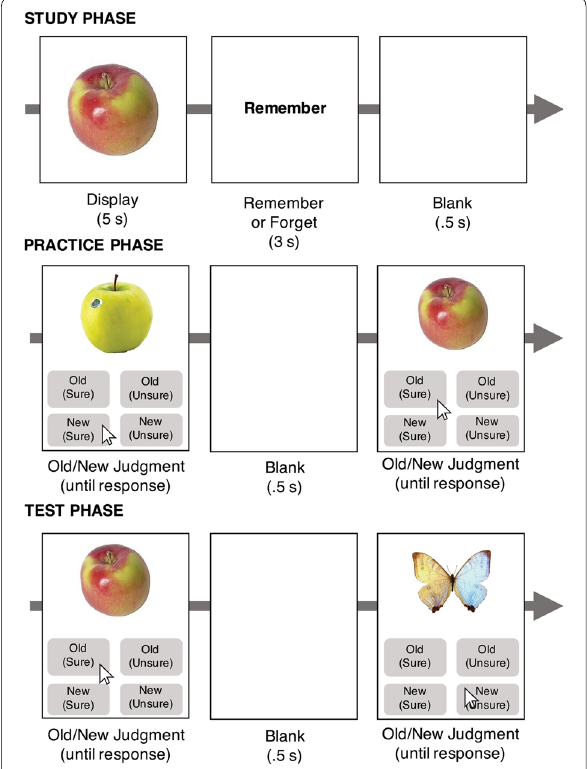
Fig. 1 Experiment 1 Methods. The experiment began with the study phase. Participants were presented with 90 objects followed by either a cue to remember (60 trials) or forget (30 trials) the